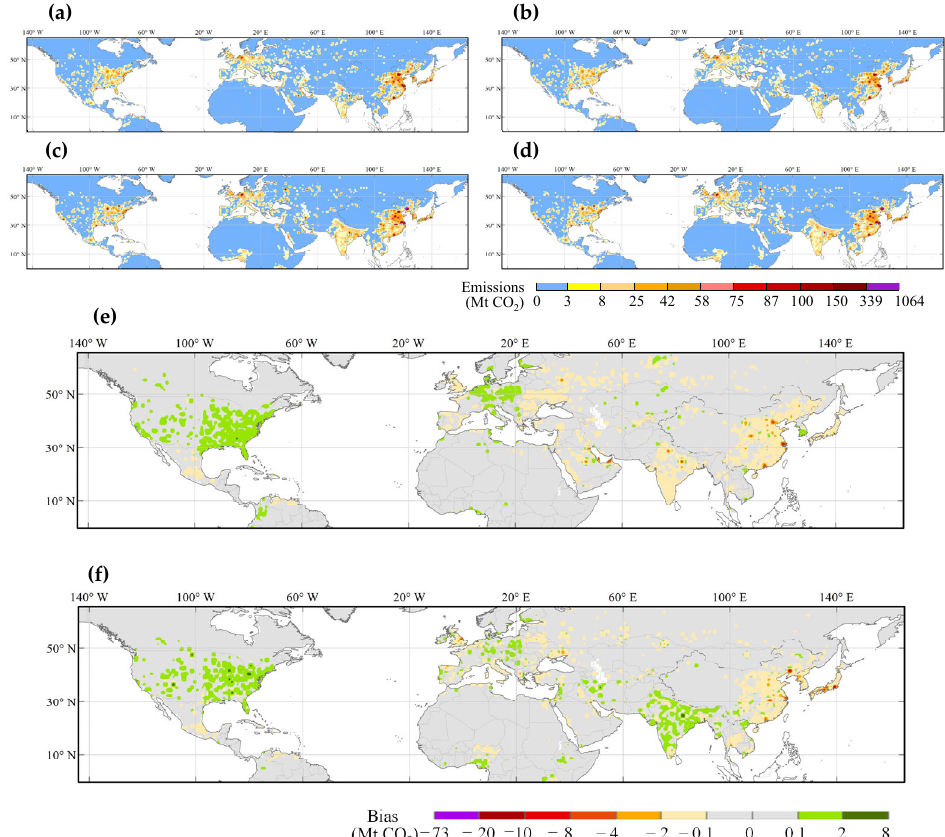
Figure 4. Averages of monthly inventories and predicted emissions based on GRNN using satellite observations in 2012 for ( a ) original ODIAC, ( b ) predicted emissions for ODIAC, ( c ) original EDGAR, ( d ) predicted emissions for EDGAR, ( e ) bias for ODIAC, and ( f ) bias for EDGAR.